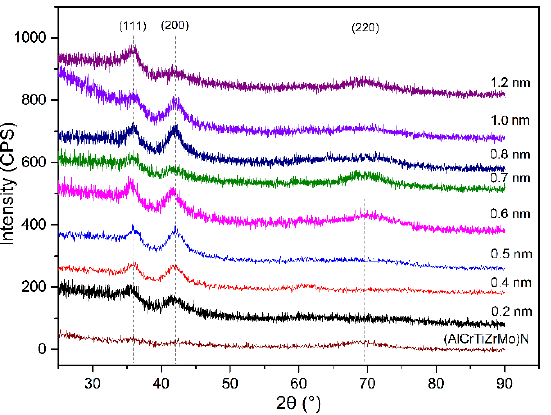
Figure 2. XRD patterns of the (AlCrTiZrMo)N/ZrO 2 nano-multilayered films with different ZrO 2 layer thicknesses.